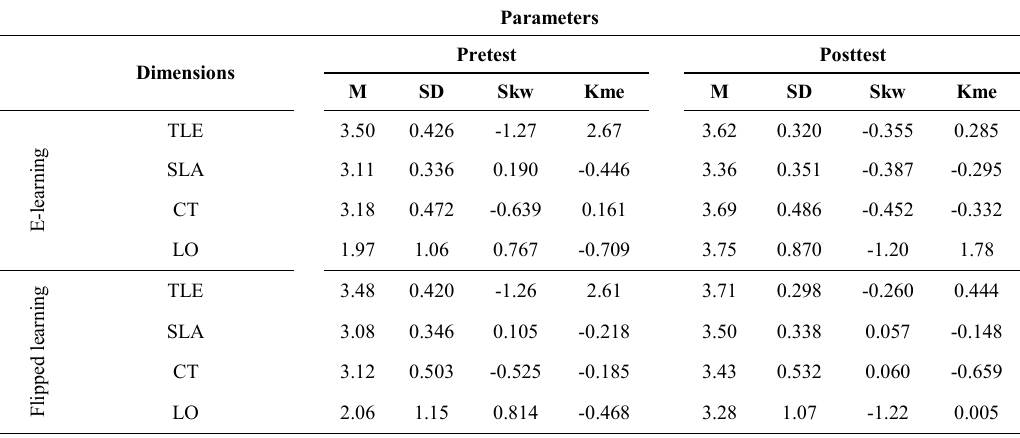
Table 1. Results obtained for the dimensions of study in e-learning and flipped learning of Secondary Education